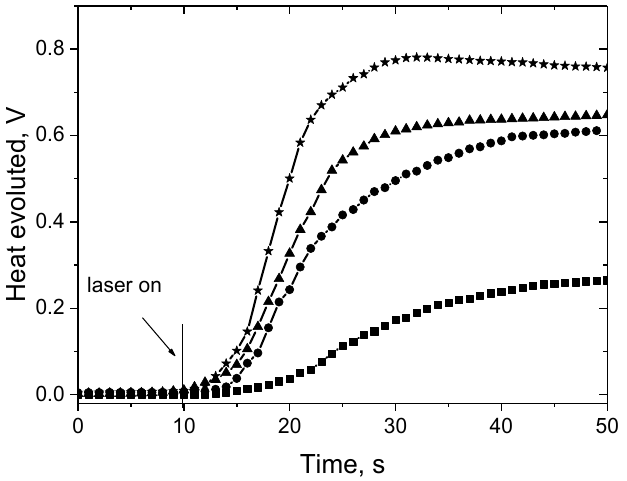
Figure 8. Family of kinetic curves recorded during the measurements of the heat flow emitted during the photoinitiated polymerization of the TMPTA-MP mixture initiated by tested dyes—[(3,4-dimethoxyphenyl)sulfanyl]acetic acid couples. The co-initiator concentration was 0.1 M, and the light intensity of the diode laser (408 nm) was 18 mW/cm 2 . The applied dyes possessed various chromophores: ⁎ —FN4, ▲ —FN2, ● —FN3, ■ —FN1.